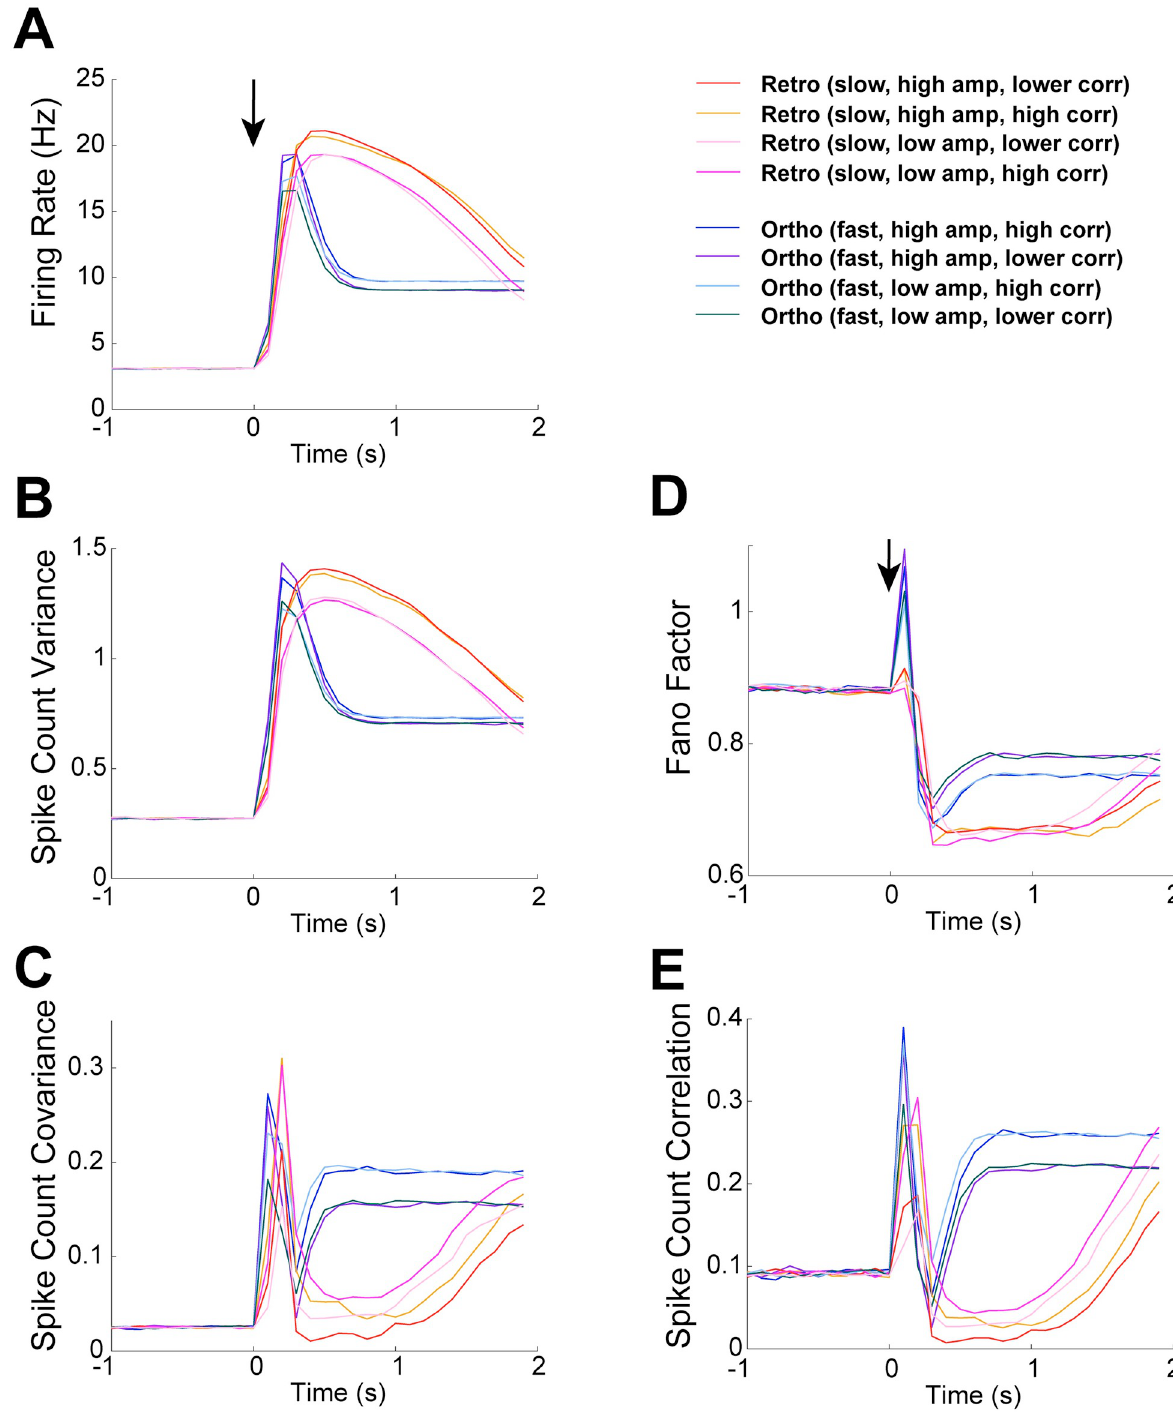
Fig 7. Comparison of all 8 OB model results. The 8 different OB model results are from varying temporal profile, amplitude height, and input correlation (2 ways each, see Fig 6A). Different temporal profiles is key for both having different model spike statistics and for best matching qualitative differences in our data (see Fig 3). A ) Firing rate in Hz (left) is slightly lower with low input rate amplitude, but no significant difference with different input correlations. B ) Spike count variance, similar to firing rate, has only slightly lower values with low input rate amplitude. C ) Spike count covariance is lower with lower input correlation for all of ortho evoked state (not surprisingly). However, retro (fast) with lower amplitude steadily increases above higher amplitude after about 1 s in the evoked state. D ) Fano Factor model results only change modestly. E ) Pearson’s spike